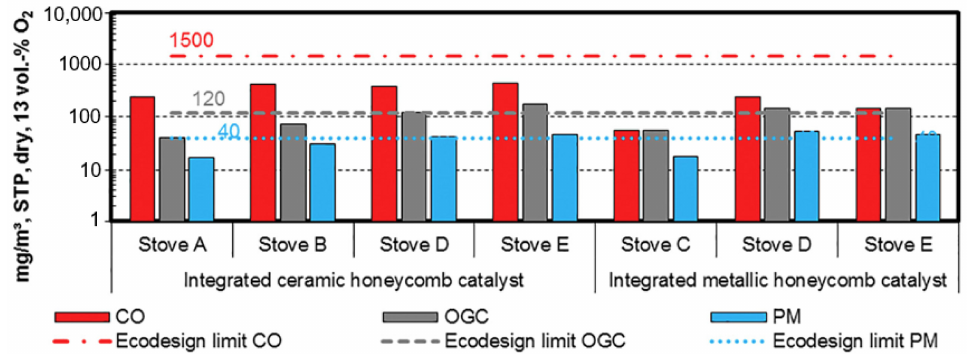
Figure 18. Average emissions with catalyst integrated solutions (ceramic and metallic catalytic honeycomb catalysts). Dashed lines represent the ELV of Ecodesign requirements for firewood stoves coming into force in 2022 [68]. Reprint with permission from G. Reichert, C. Schmidl, W. Haslinger, H. Stressler, R. Sturmlechner, M. Schwabl, M. Wöhler, C. Hochenauer, Impact of